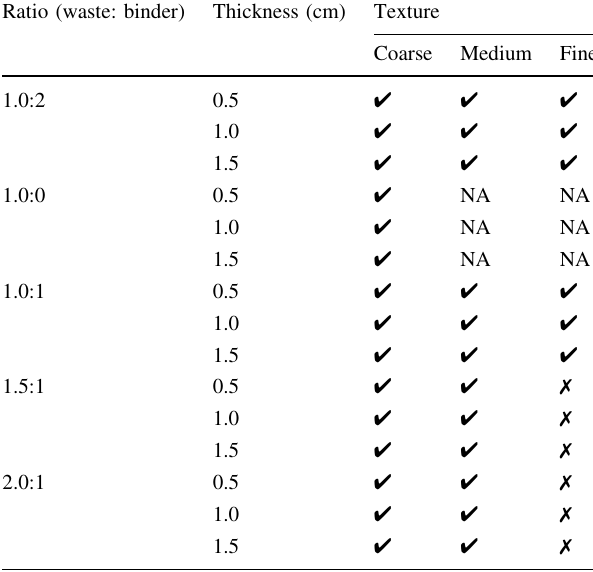
Table 2 Forming size capabilities of pineapple waste textures